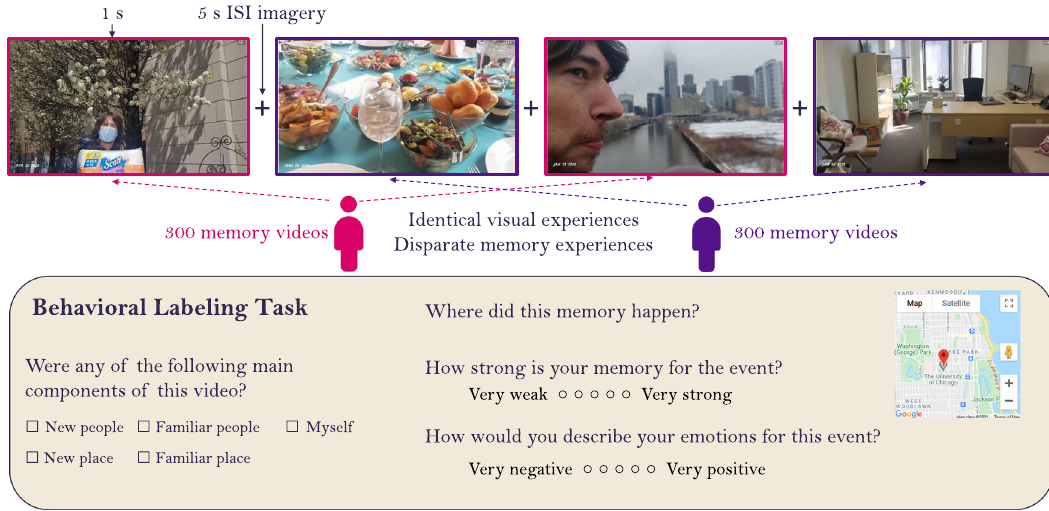
Fig. 1 | Experimental methods. For the in-scanner task, participants viewed a randomly intermixed sequence of 1-second videos, consisting of approximately 300oftheirownmemoryvideosand300memoryvideosfromapairedparticipant. This participant pair saw the exact same videos in the same order, so their visual experiences were identical, but their memory experiences were non-overlapping, only recognizing their own videos and not recognizing the videos of the paired participant. After viewing a 1s video, participants had a 5s interstimulus interval